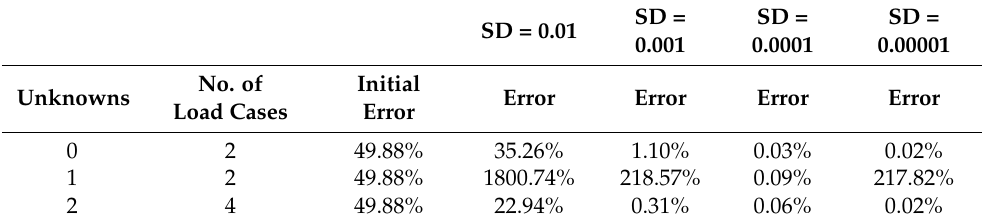
Table 9. Errors obtained for the thermal parameters for transient 7 nodes model.